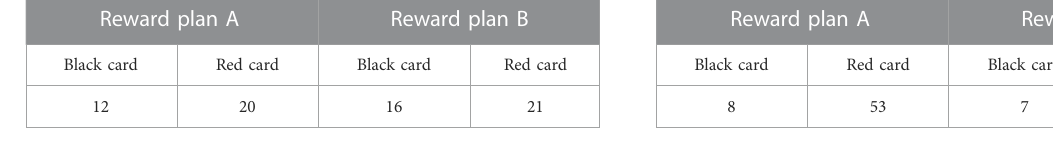
TABLE 1 Test procedure, unit: yuan. Reward plan A